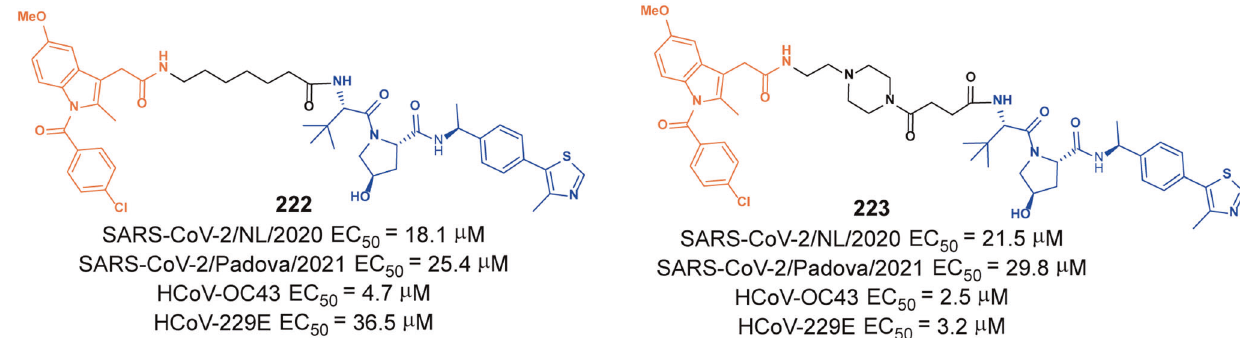
Fig. 73 The representative PROTACs targeting pan-coronavirus antiviral